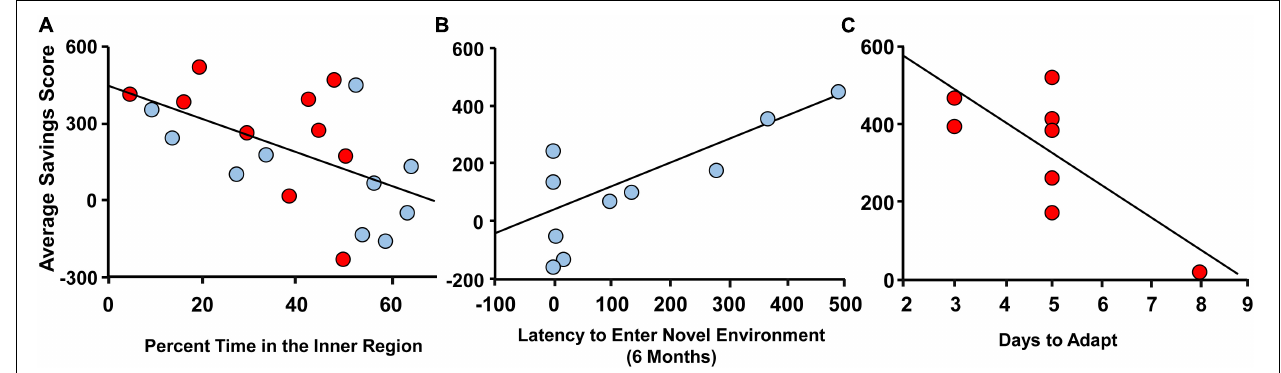
FIGURE 6 | Correlates of variability in spatial memory at 12 months. Spatial memory at 12 months, measured as average savings scores, for males (blue circles) and females (red circles) plotted against (A) percent time in the inner region of the open field at 12 months, (B) latency to enter the novel environment at 6 months, and (C) days to adapt to a shift in light/dark cycle at 12